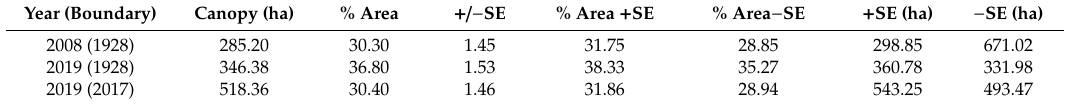
Table 6. i-Tree’s stratified random sampling, standard error of canopy change statistics.